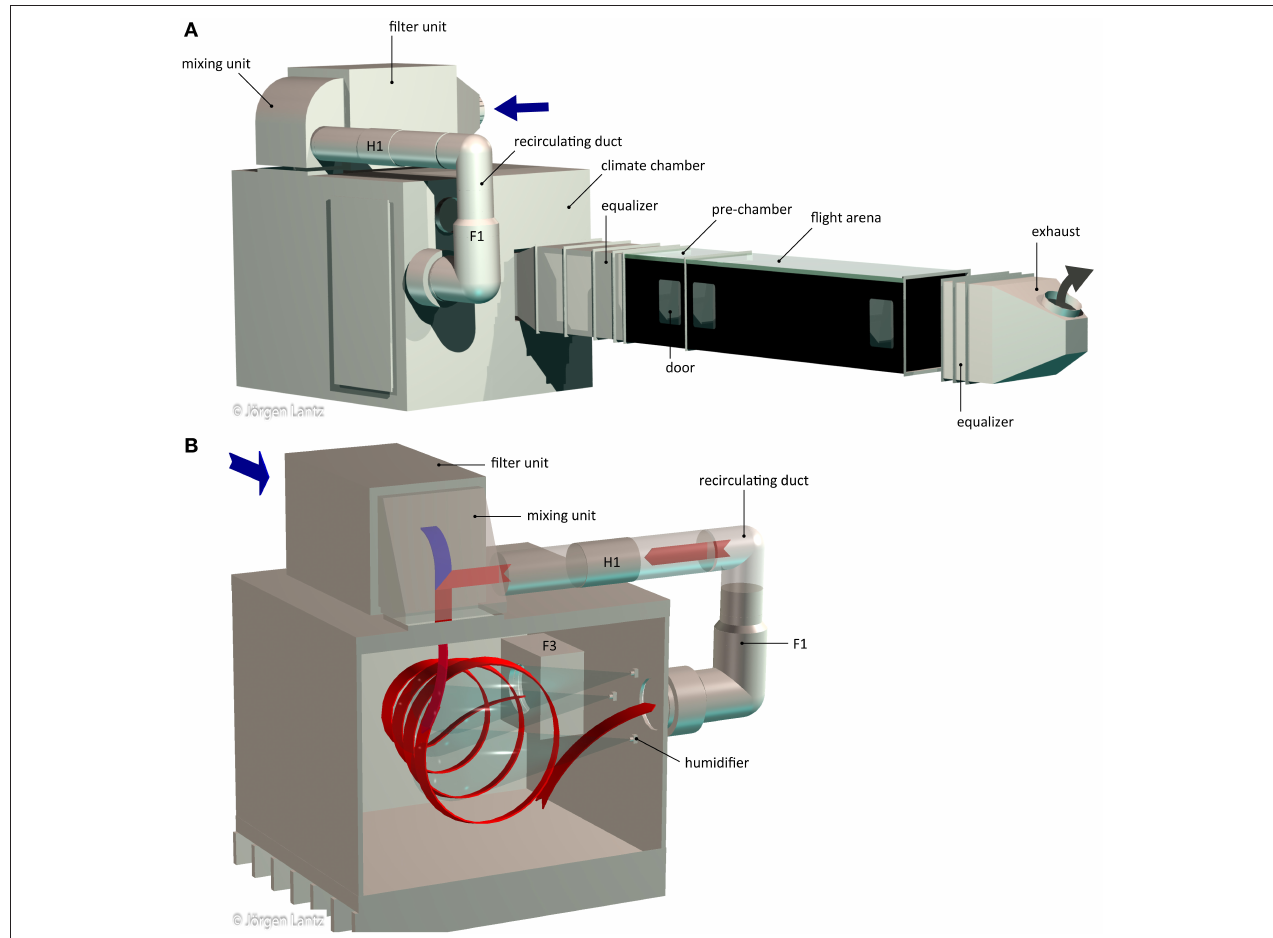
FIGURE 1 | Schematic of the wind tunnel system (A) and climate chamber (B) . Incoming air (blue) is filtered in the filter unit and passed on to the mixing unit where it is mixed with warm air (red) from the recirculating duct. In the climate chamber, the air is humidified by five humidifiers (three shown) and passed on through an equalizer toward the pre-chamber and flight arena. Both pre-chamber and flight arena can be accessed by doors. Air is removed by the exhaust. F1 and F3 indicate the fans and H1 the heater. F2 and the flow control valve are placed on the feeding line to the wind tunnel system and thus not shown.